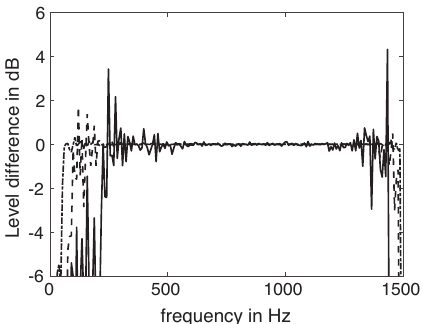
Figure 20. Level difference between original source strength and reconstructed source strength for pattern N p = 3 for three different amplitudes: .-. 10 (cid:3) 4 , - - 10 (cid:3) 5 , — 10 (cid:3) 6 and the ampli- tudes for the pattern N p = 1, 2, 4, 5 set to